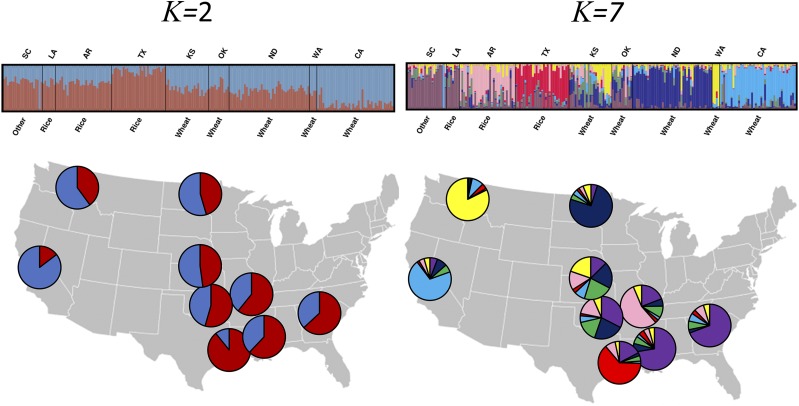
Structure plot of R. dominica across the United States. Vertical bars represent individuals whose genotype have been portioned into 2 and 7 clusters. Below each location is the predominate crop at the sampled region. Colors in pie charts represent the percentage of assignment (Q value) of each group).